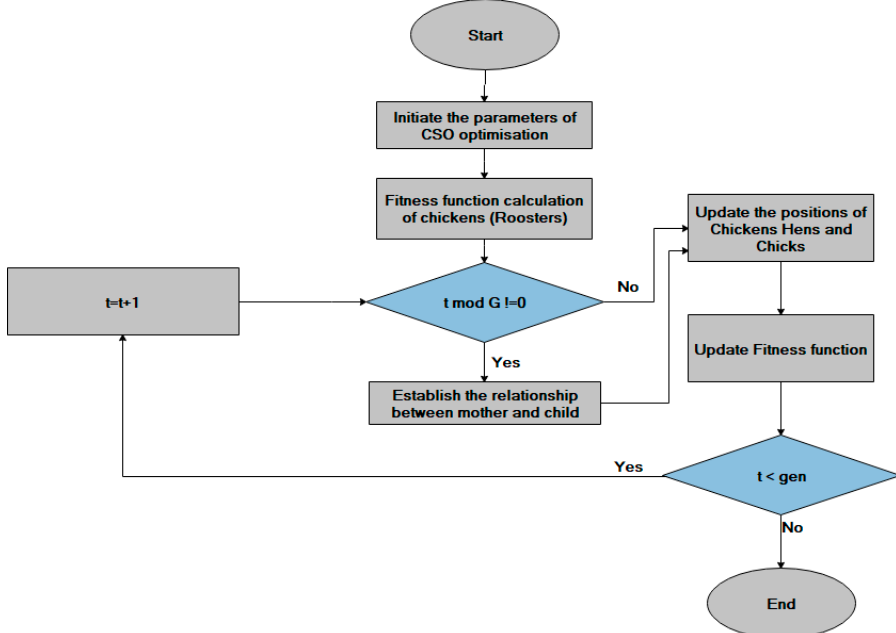
Figure 7. Chicken Swarm optimization Flowchart. The movement of chickens mainly depends on the ability to search for food of the different members of the cluster, which is updated according to the fitness values of the initial population. The movement can be formulated as